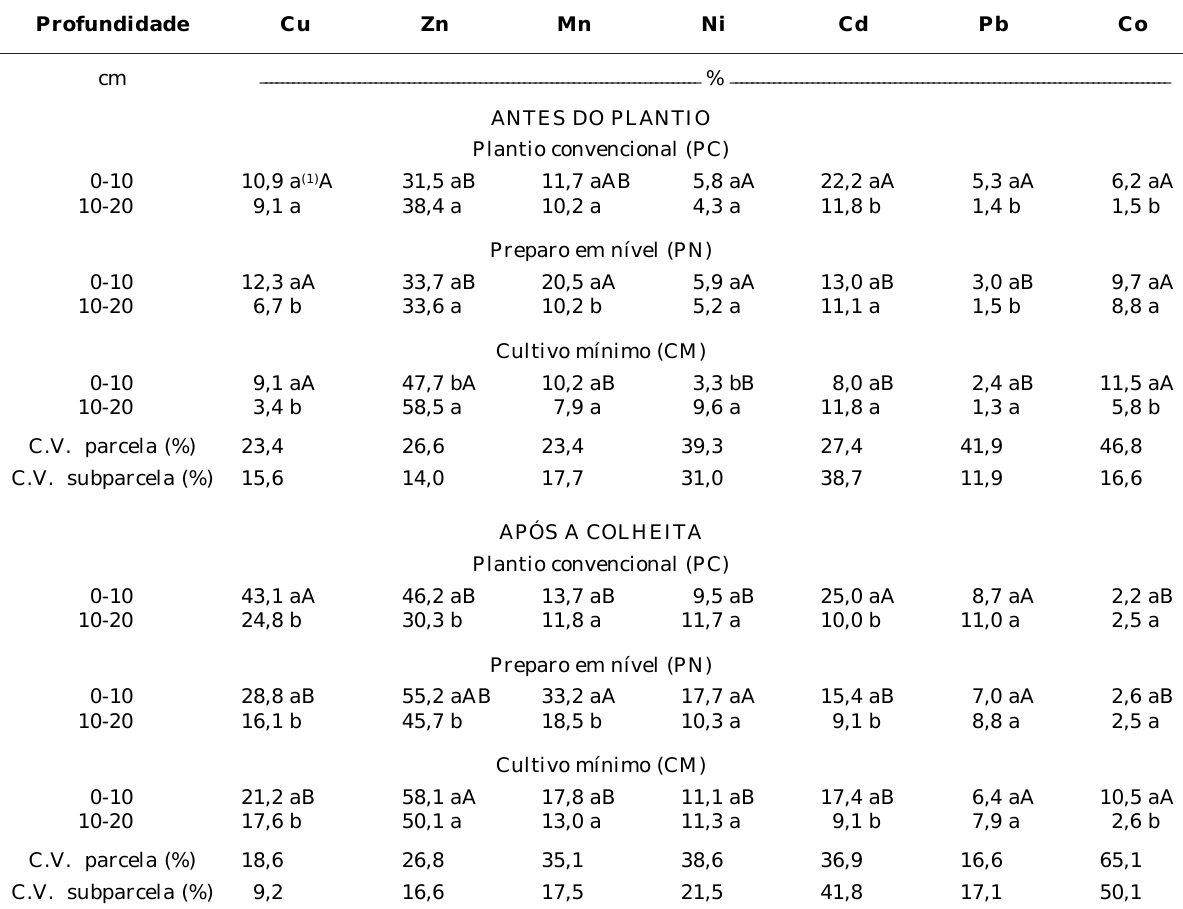
Quadro 5. Percentagens dos totais de metais pesados no solo determinados após extração com EDTA 0,05 mol L -1 , nos três sistemas de preparo do solo